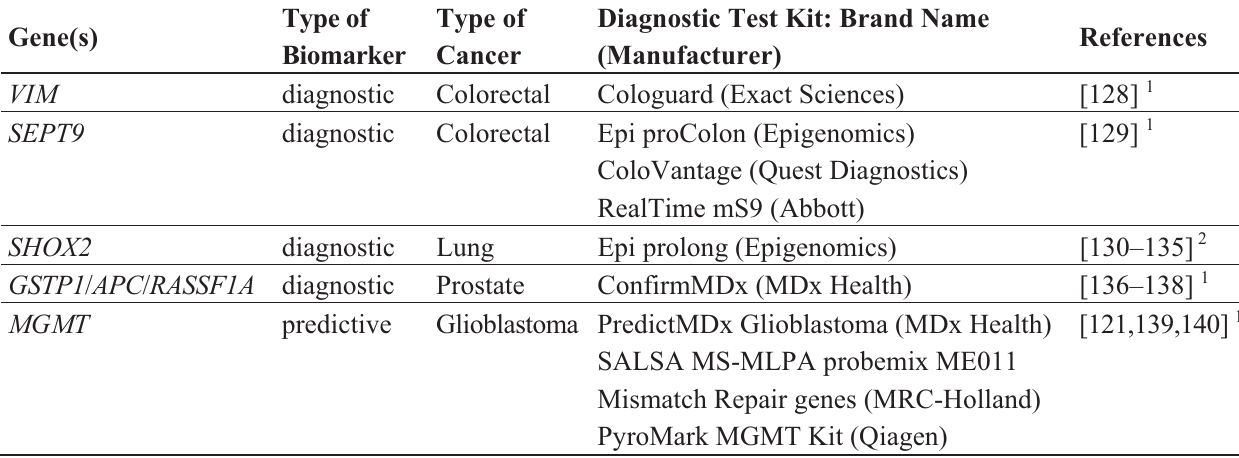
Table 2. Commercially-available DNA methylation test kits for cancer. References are either systematic reviews/meta-analyses 1 or a set of corroborating references 2 . This table is an updated version of that shown in